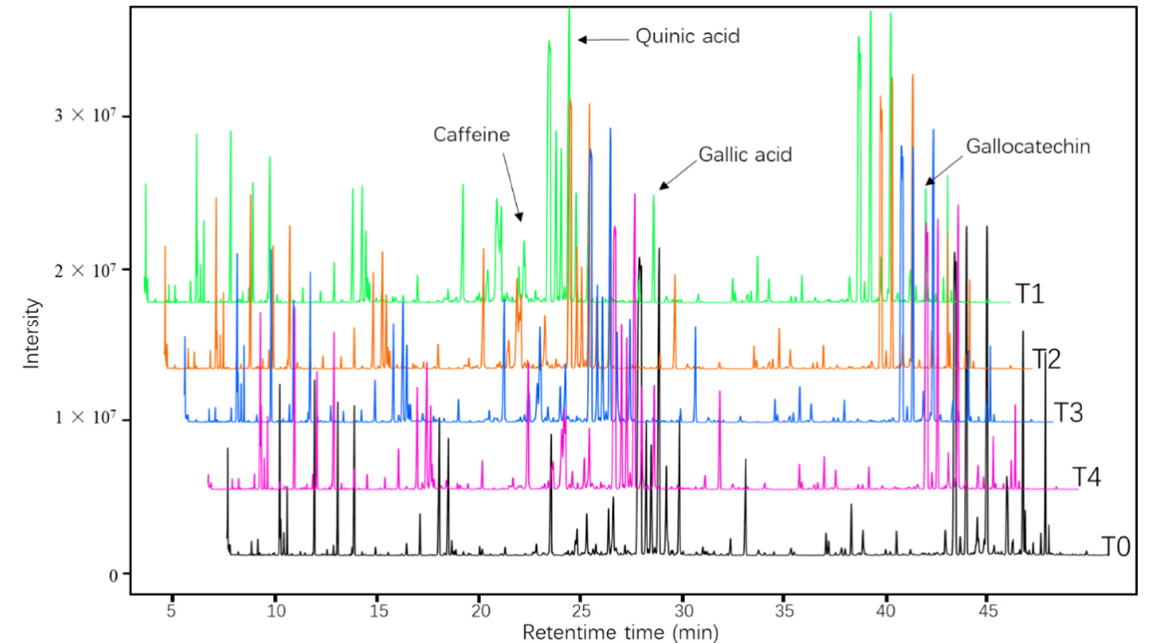
Figure 2. Total ion chromatograms of metabolites in young tea shoots under recommended amount of nitrogen (N), phosphorus (P), and potassium (K) application (T1), high P application (T2), high K application (T3), high P and K application (T4), and control (T0) treatments analyzed by gas chromatography-mass spectrometry (GC-MS).